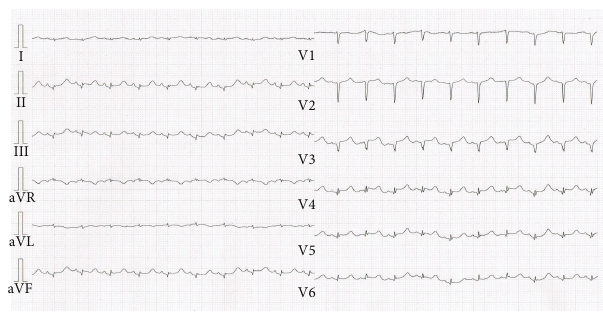
Figure 1: Electrocardiogram showed significant ST-elevation in leads II, III, aV F , and V 3